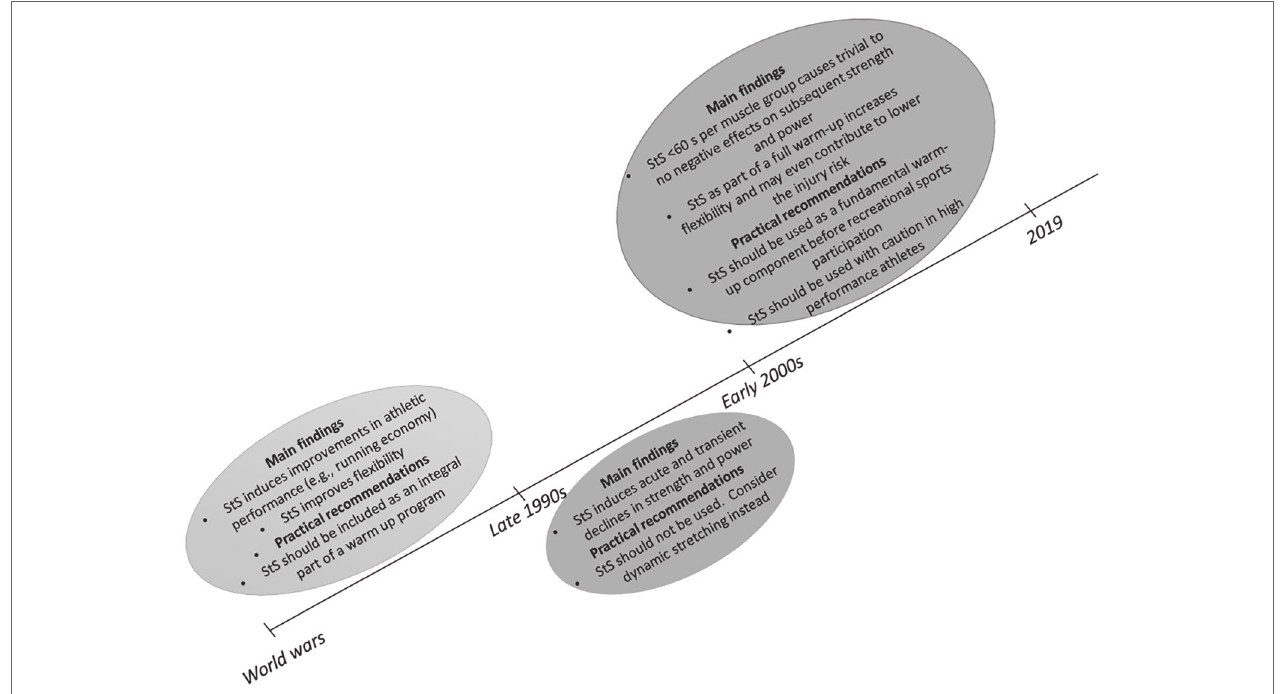
FIGURE 1 | Timeline of the controversial mindset about the acute effects of static stretching (StS) on strength and power